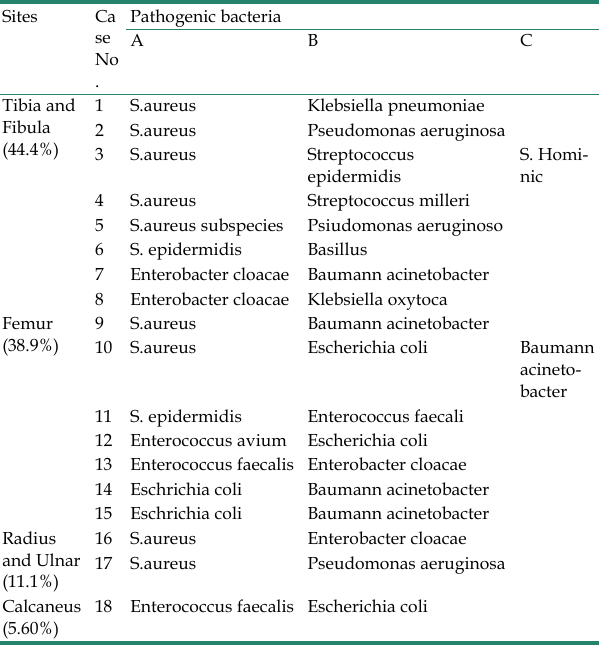
Table 4. Mix infection: Sites and pathogenic bacteria Sites Ca se No .